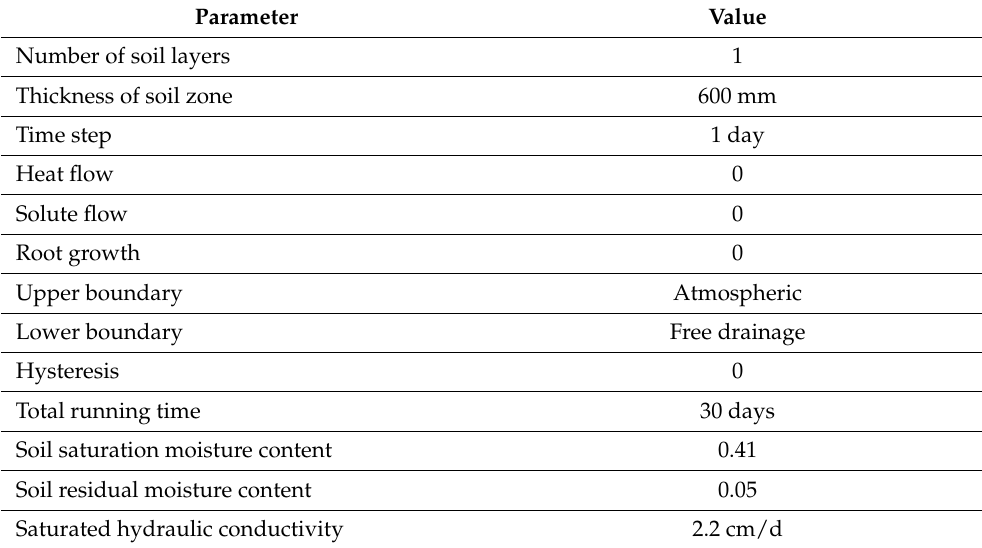
Table 1. Values of main parameters used in Hydrus